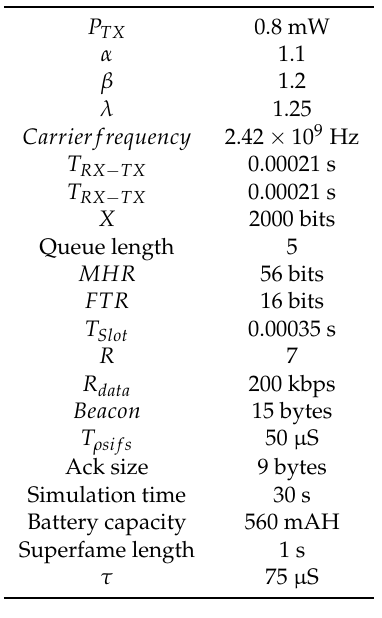
Table 4. Simulation